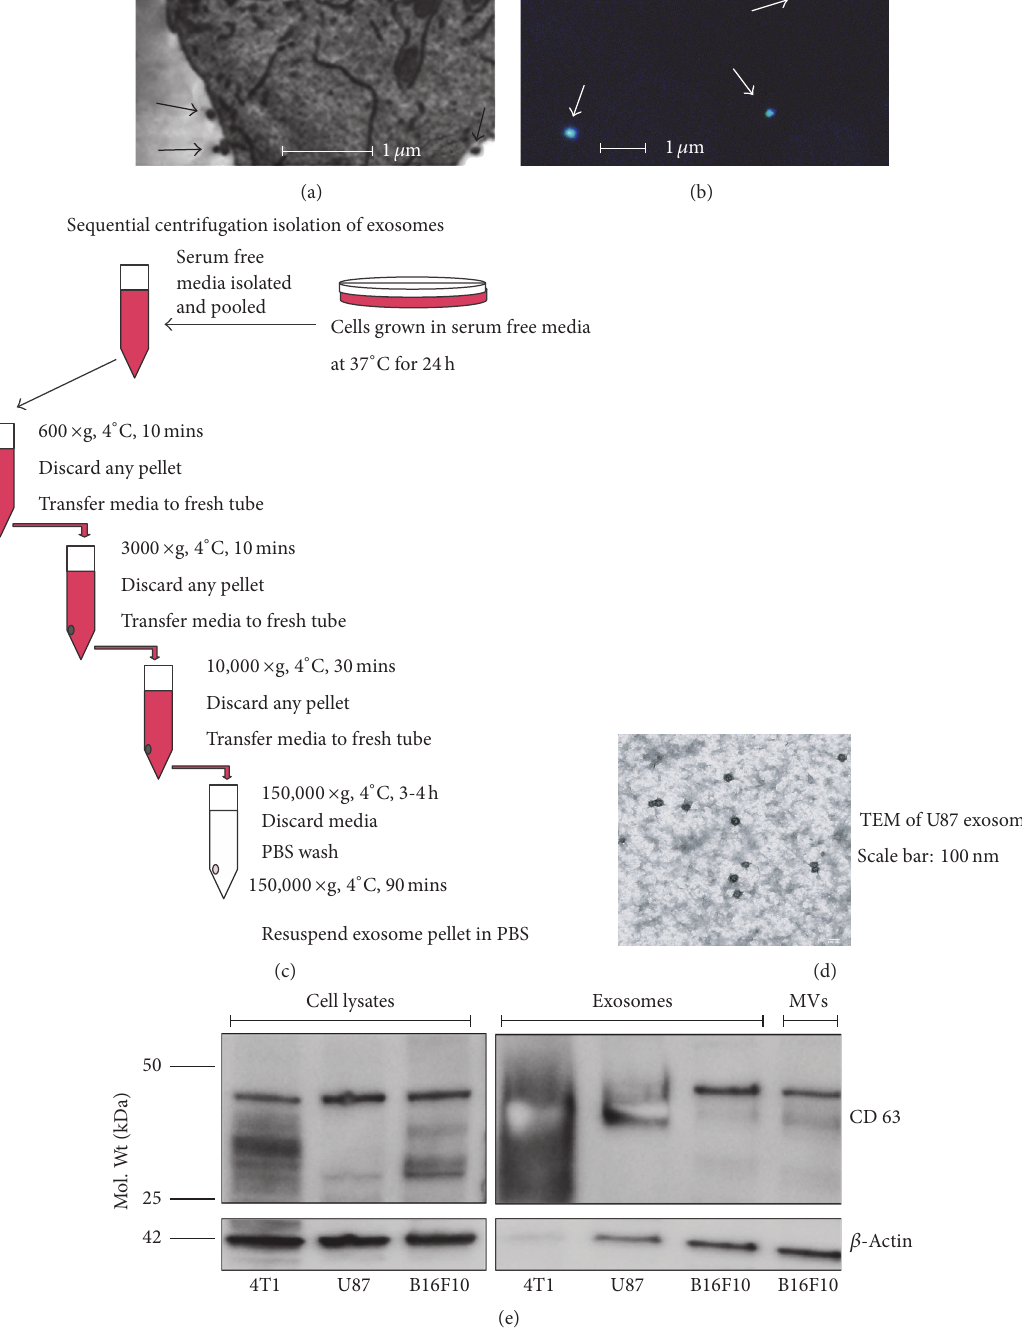
Figure 2: In vitro characterization and imaging of exosomes. (a) TEM image of B16F10 melanoma cell fragment with exosomes (arrows). (b) Dark field image of exosomes from B16F10 melanoma cells (light scattering contrast). (c) Schematic of exosome isolation. (d) TEM image of U87 exosomes. (e) Western blot of U87, 4T1, and B16F10 cell lysates and exosomes.